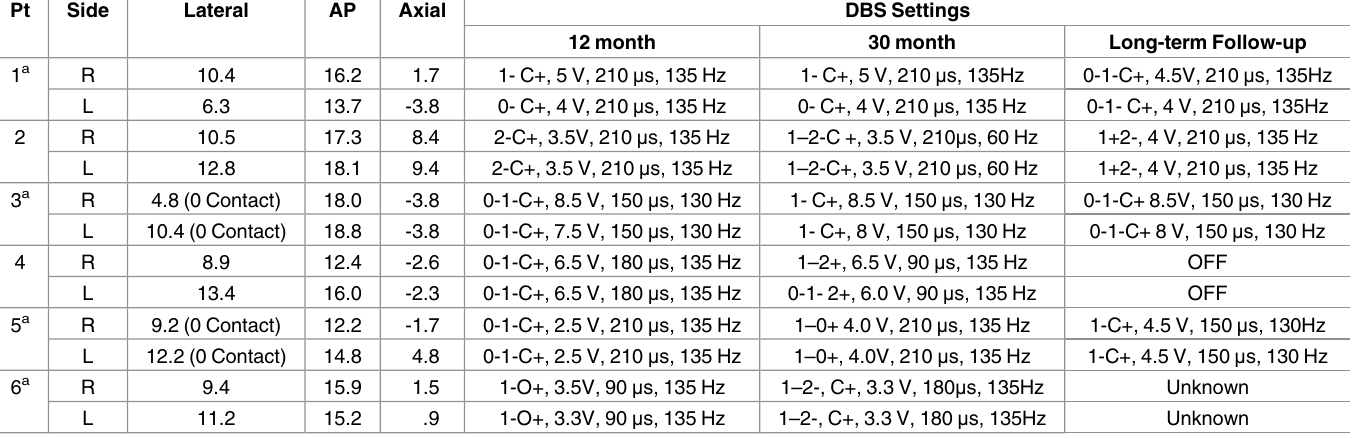
Neuropsychological Scores. Echoing findings from the original 6 and 12 month follow- ups,[11] there was no indication of neuropsychological impairment when the MoCA was administered at the end of the follow-up period. Specifically, all subjects scored at least 27 on the assessment, exceeding the clinical screening score of 26.[18] DBS Lead Locations and Programming. See Table 3 for a summary of the DBS contacts used for chronic stimulation and the programming settings. Four of six subjects had different settings at 12-month, 30-month, and long-term follow-up. One subject was no longer receiv- ing active DBS and the other subject did not provide consent to obtain medical records for current DBS settings. Table 3.